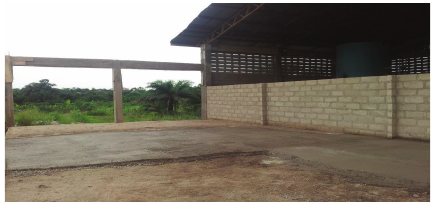
Figure 3: Concrete works at CSIR-BRRI pozzolana factory involv- ing beams, columns, block works, and mass concrete.